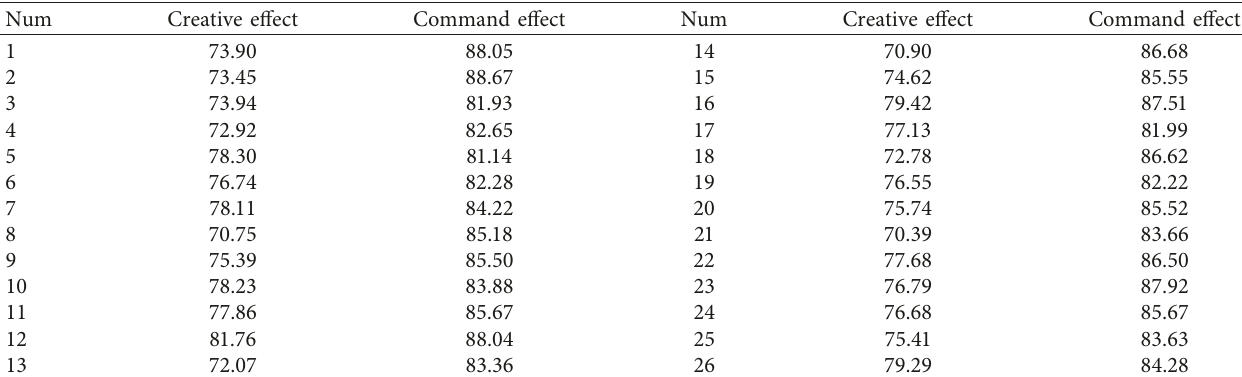
Table 1: The effect evaluation of the symphony intelligent creation and command system based on artificial intelligence.